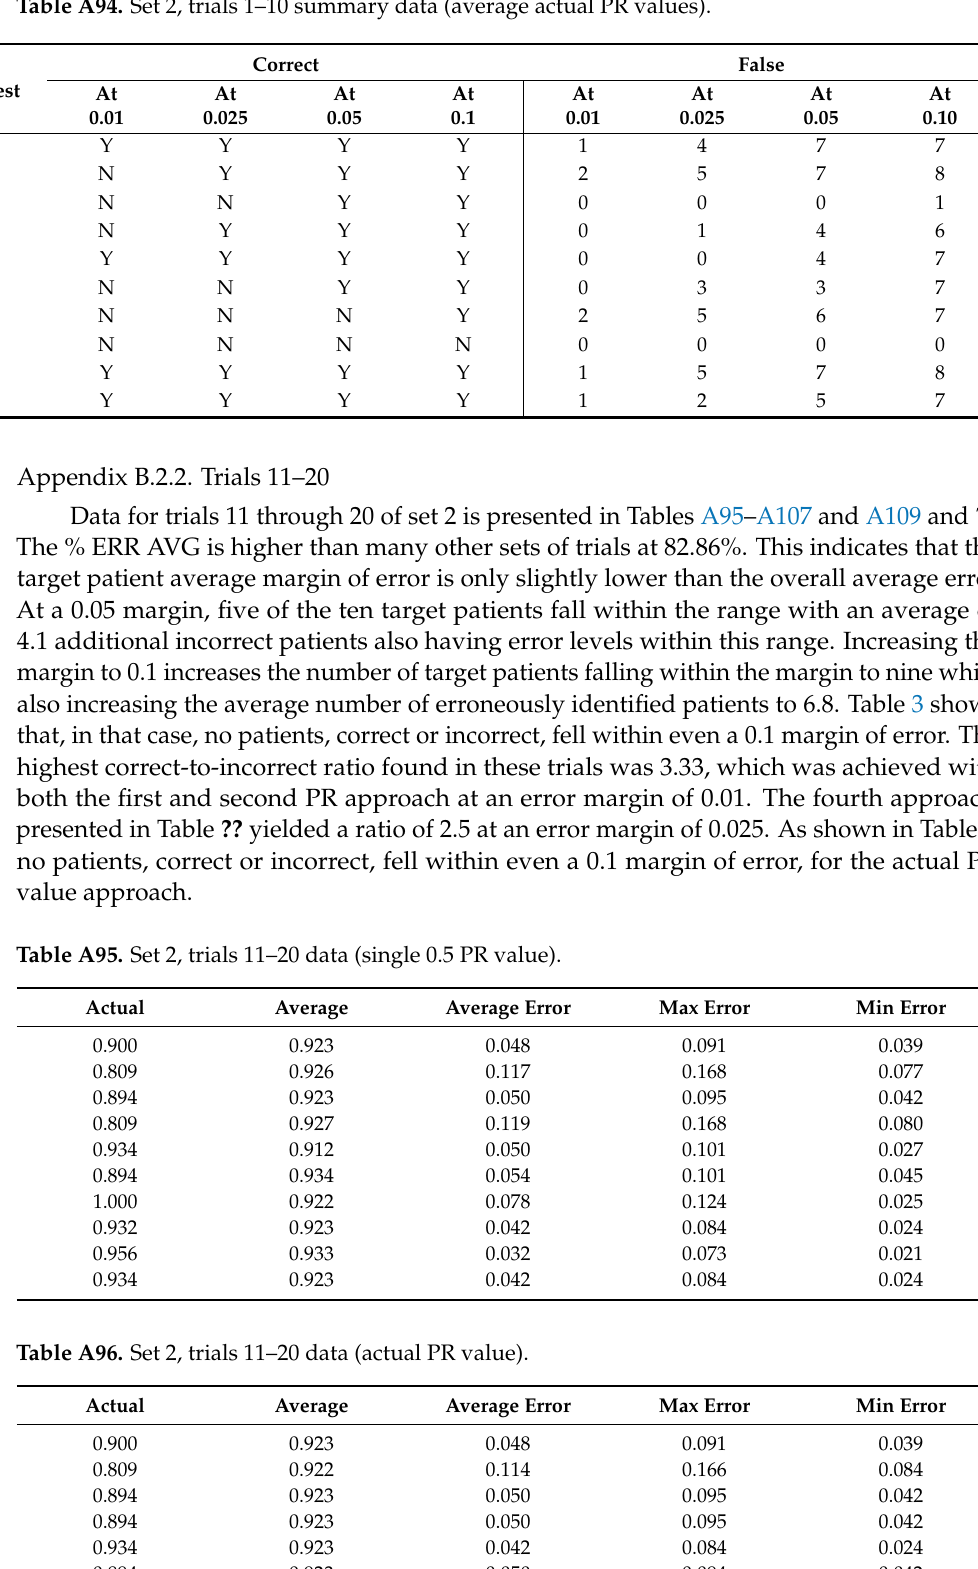
Table A94. Set 2, trials 1–10 summary data (average actual PR values).